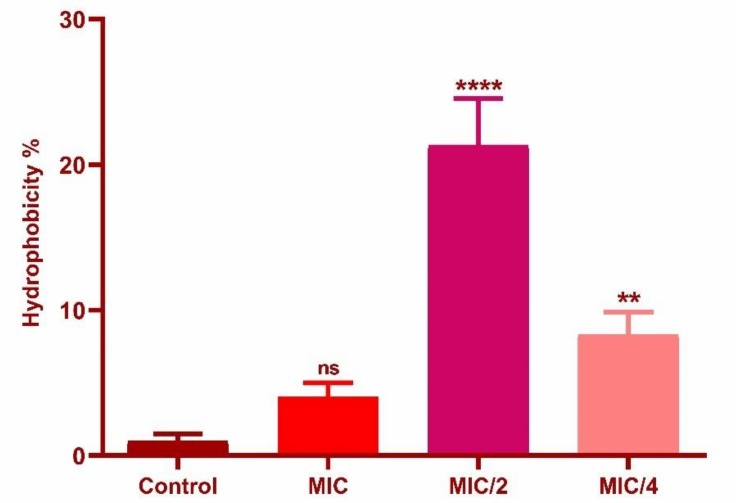
Figure 12. Hydrophobicity percentage of L. fermentum ASBT-2 with MIC and sub-MIC concentra- tions of oxyresveratrol. **** Significantly different ( p ≤ 0.0001); ** significantly different ( p ≤ 0.01); ns: